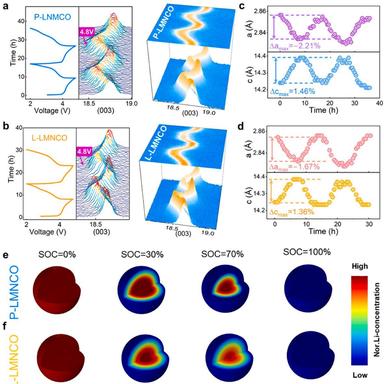
Lattice evolution and Li + concentration distribution of P-LMNCO and L-LMNCO cathodes. (a,b) In situ XRD patterns of (003) and (104) peaks and (c,d) the evolutions of lattice parameters of P-LMNCO and L-LMNCO cathodes during initial two cycles; (e,f) the normalized simulation results of Li+ concentration distribution in P-LMNCO and L-LMNCO particles at several states of charge (SOC).